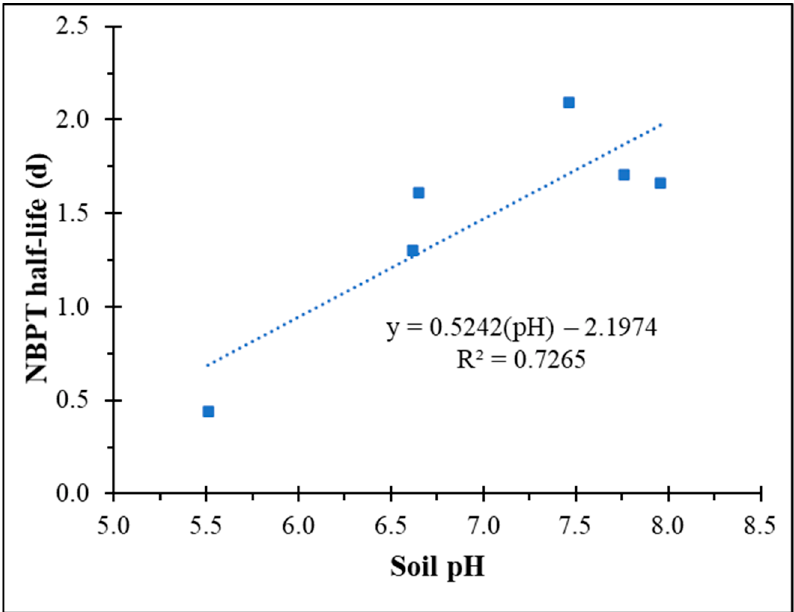
Figure 2. Relationship between soil pH and NBPT half-life. Y is NBPT half-life in soil.